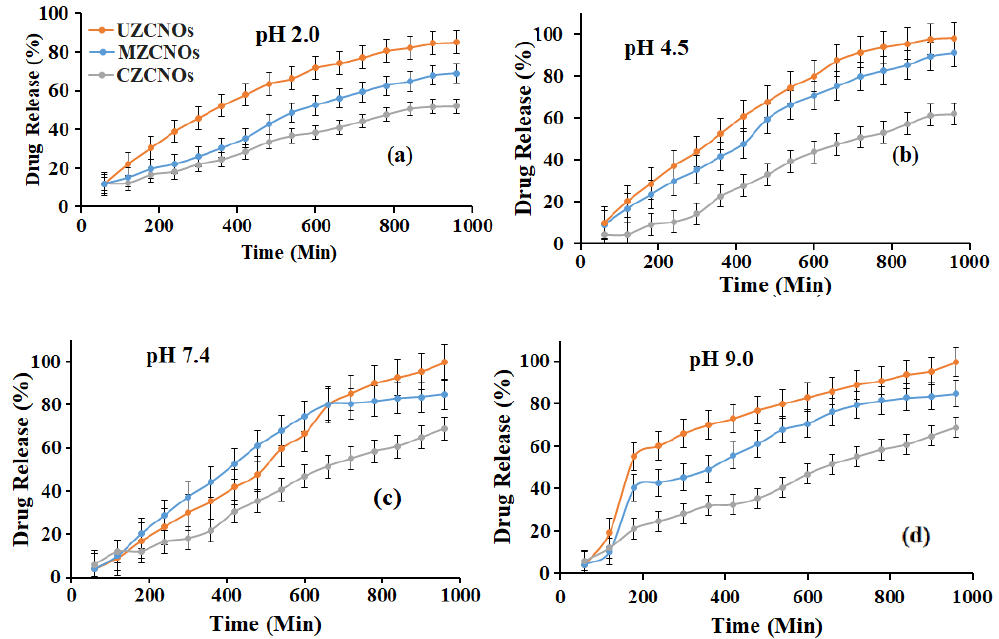
Figure 6. The graph illustrating the cumulative release of 5-FU from CZCNOs, MZCNOs, and UZCNOs composite hydrogels in DMEM at ( a ) pH 2.0, ( b ) pH 4.5, ( c ) pH 7.4, and ( d ) pH 9.0 at 37 °C, respectively.